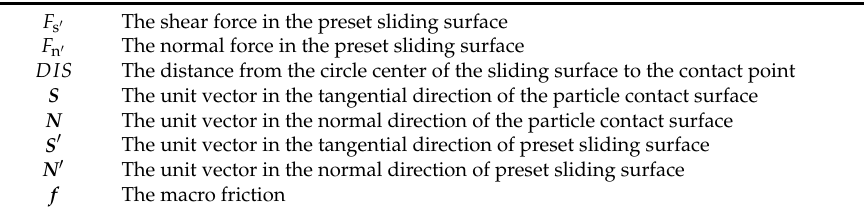
Table 1 The parameters adopted to calculate the safety factor. Table 1. The parameters adopted to calculate the safety factor.